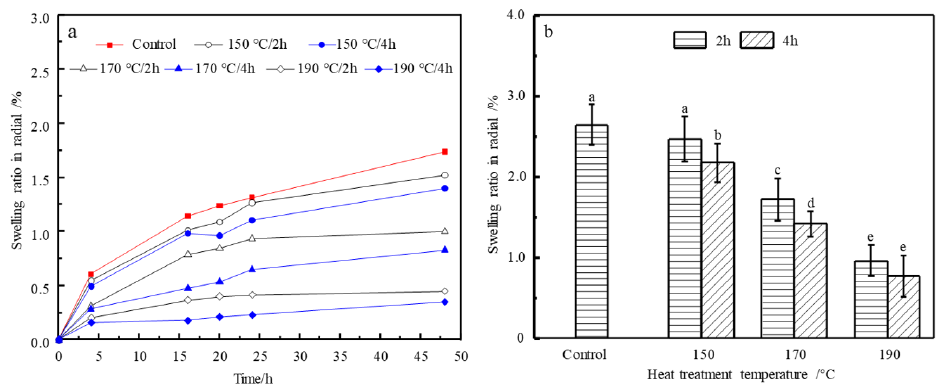
Figure 5. Radial swelling in short-term water vapor sorption process ( a ) and at EMC of the control and HT wood ( b ). Bars with different letters indicate significant differences ( p < 0.05) according to Duncan’s multiple range tests.